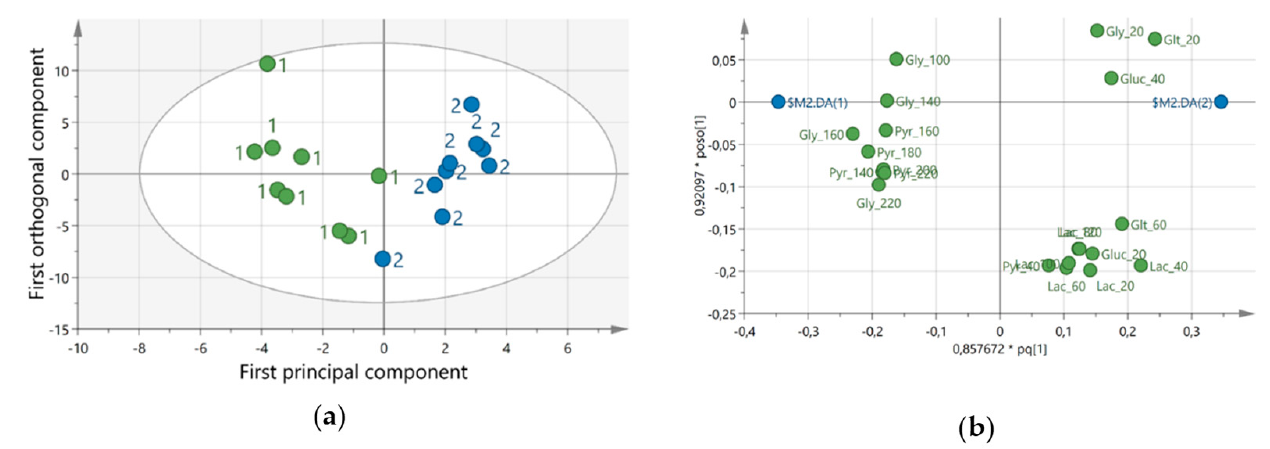
Figure 5. Multivariate data analysis of the metabolite. ( a ) represents the score plot of the orthogonal partial least square discriminant analysis (OPLS-DA) showing a clear separation between samples from before (green circles) dynamic computer working (DCW) and after (blue circles) 4-weeks DCW using DynaDesk. ( b ) illustrates the loading plot for the OPLS-DA model showing the substances (Gly = glycerol, Glt = glutamate, Pyr = pyruvate, Lac = lactate, Gluc = glucose) that are important for the separation between the groups. The substances are listed in Supplementary Table S1.